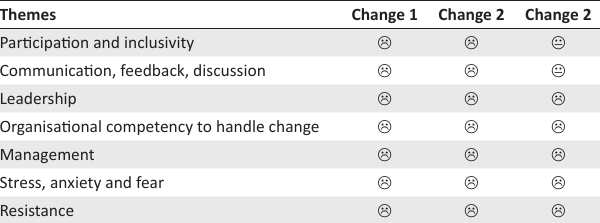
TABLE 2: Case study themes